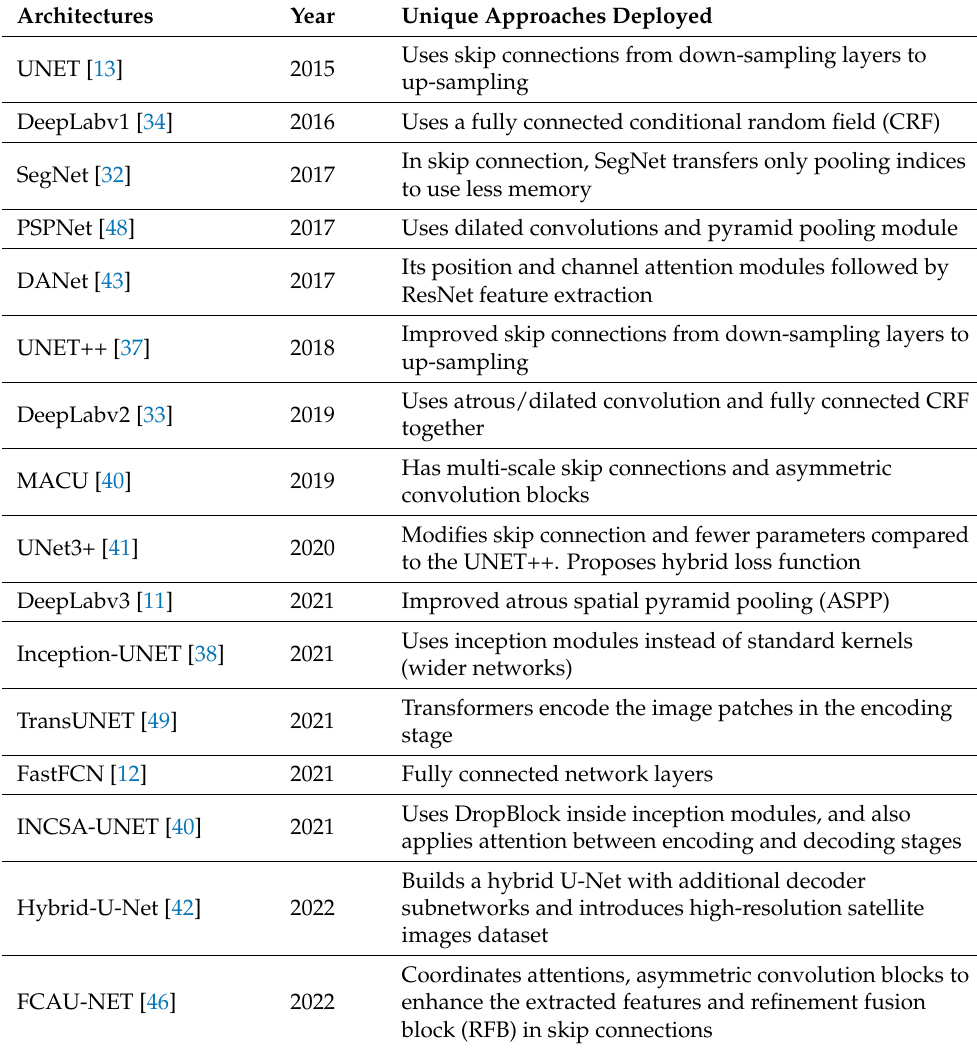
Table 1. Breakdown of manually designed neural networks for semantic